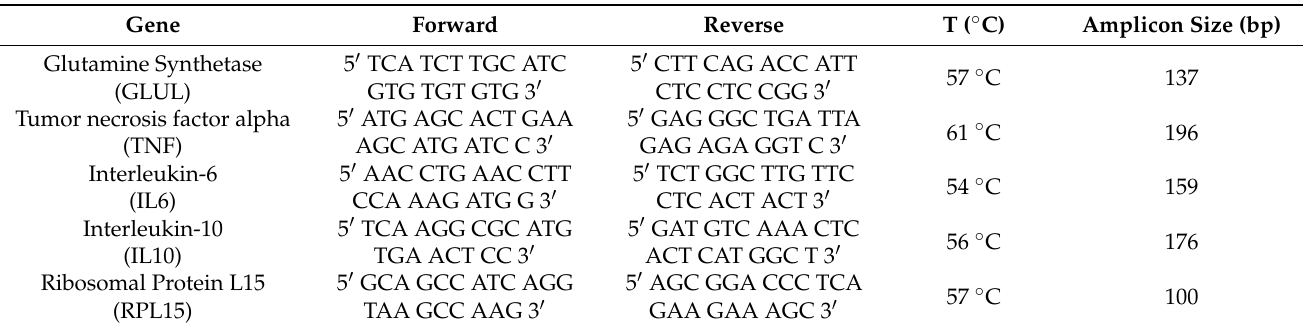
Table 1. Primers used for studies of gene